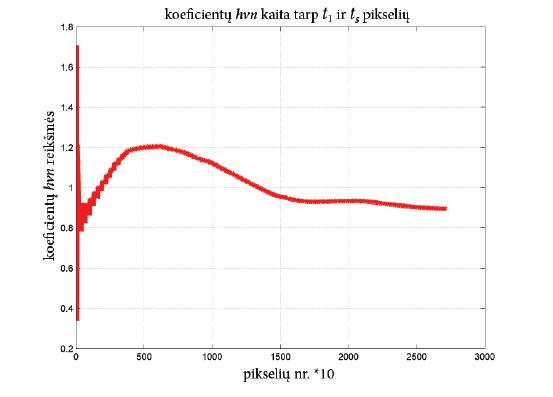
Fig. 4. Normalized covariance function of the digital image for the lens of the eye with contact lens